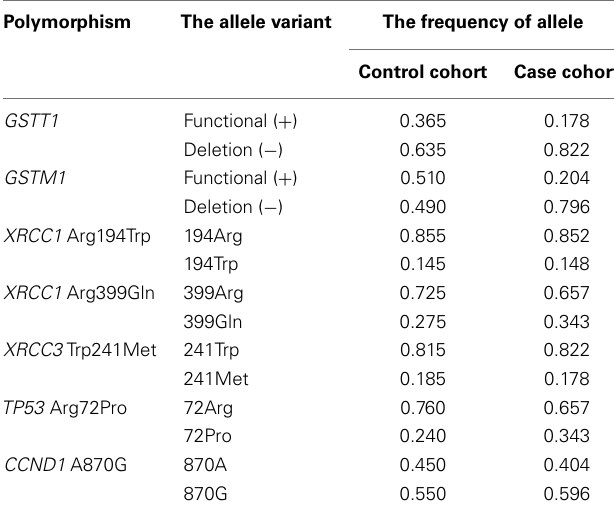
Table 3 |The frequencies of alleles of candidate genes in control and case cohorts for esophageal